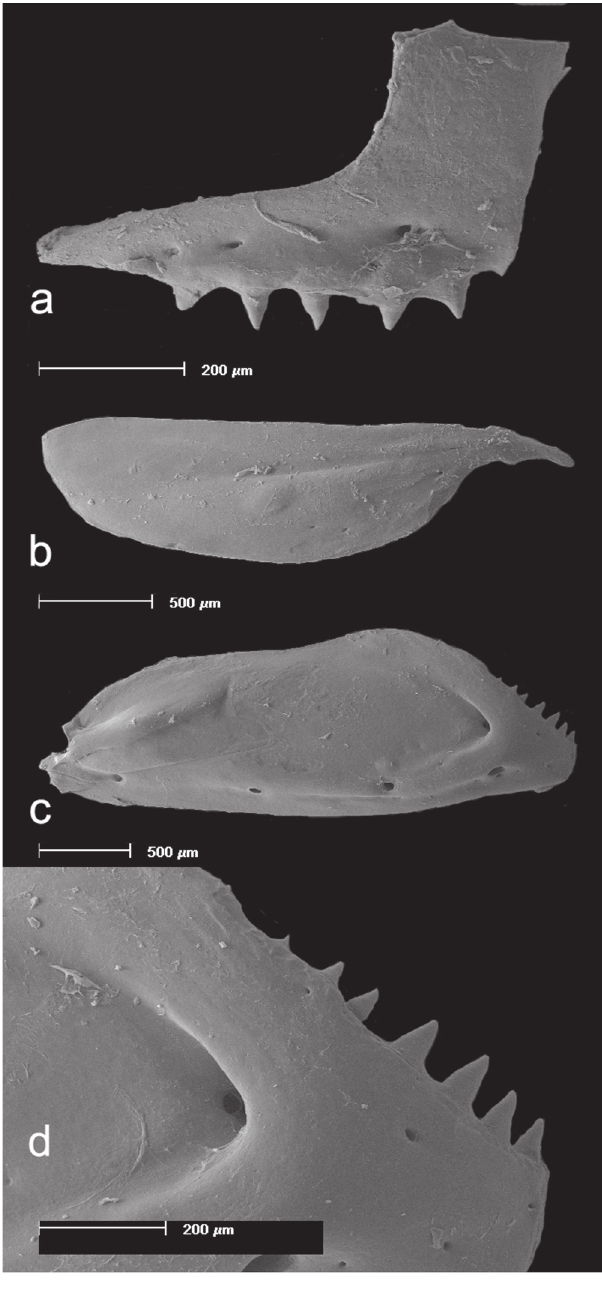
Fig. 2. Macropsobrycon uruguayanae , MCP 20900, 27.9 mm SL; Scanning Electron Microscopy (SEM) images showing a - right side premaxilla, b - maxilla , and c - dentary, with d - detail of the